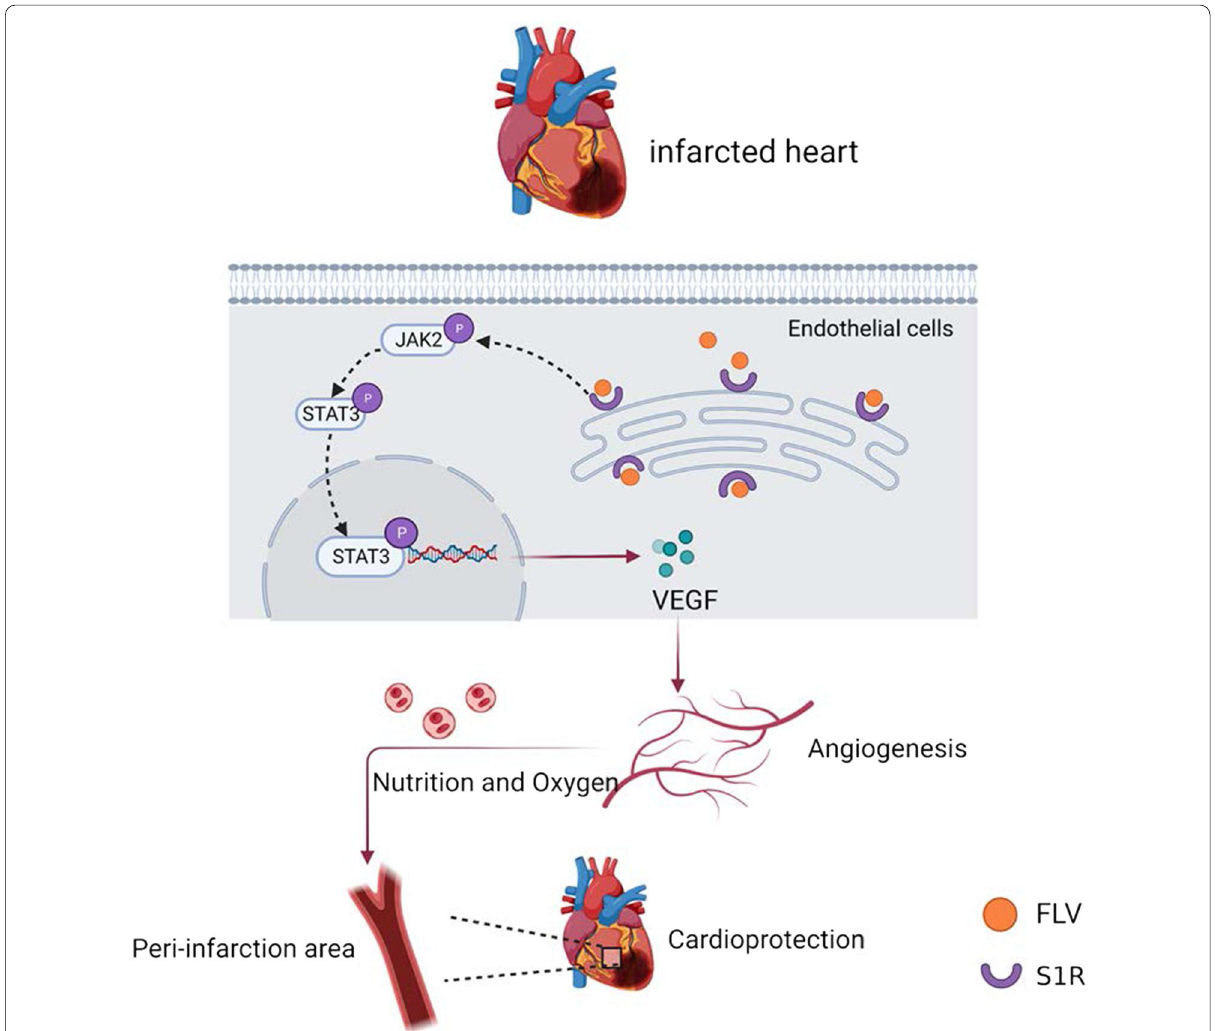
Fig. 7 Schematic representation of the angiogenesis effect of S1R stimulation in the PIHF rats. Stimulation of S1R exerts protective effect in PIHF, which were associated with augmentation of microvascular density in peri-infarct region through activation of the JAK2/STAT3